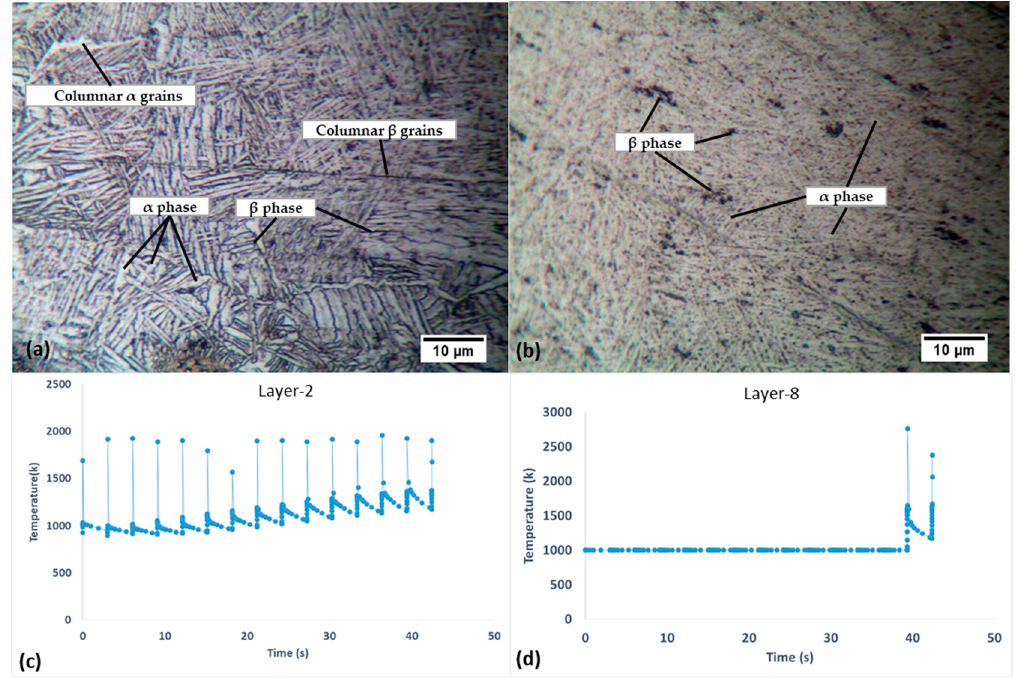
Figure 23. Microstructures obtained by microscope for Ti-6Al-4V alloys vs. current simulated model temperature profiles. ( a ) At 0.075 mm above the base plate (layer-2). ( b ) At 0.375 mm above the base plate (layer-8). ( c ) Temperature profile for layer-2. ( d ) Temperature profile for layer-8.